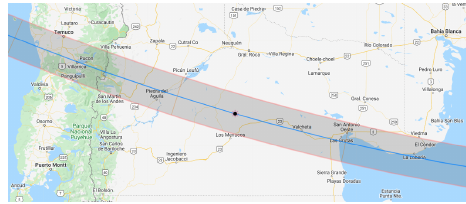
Figure 2: (left) mobile station installed during the eclipse in Valcheta. (right) Instrumental